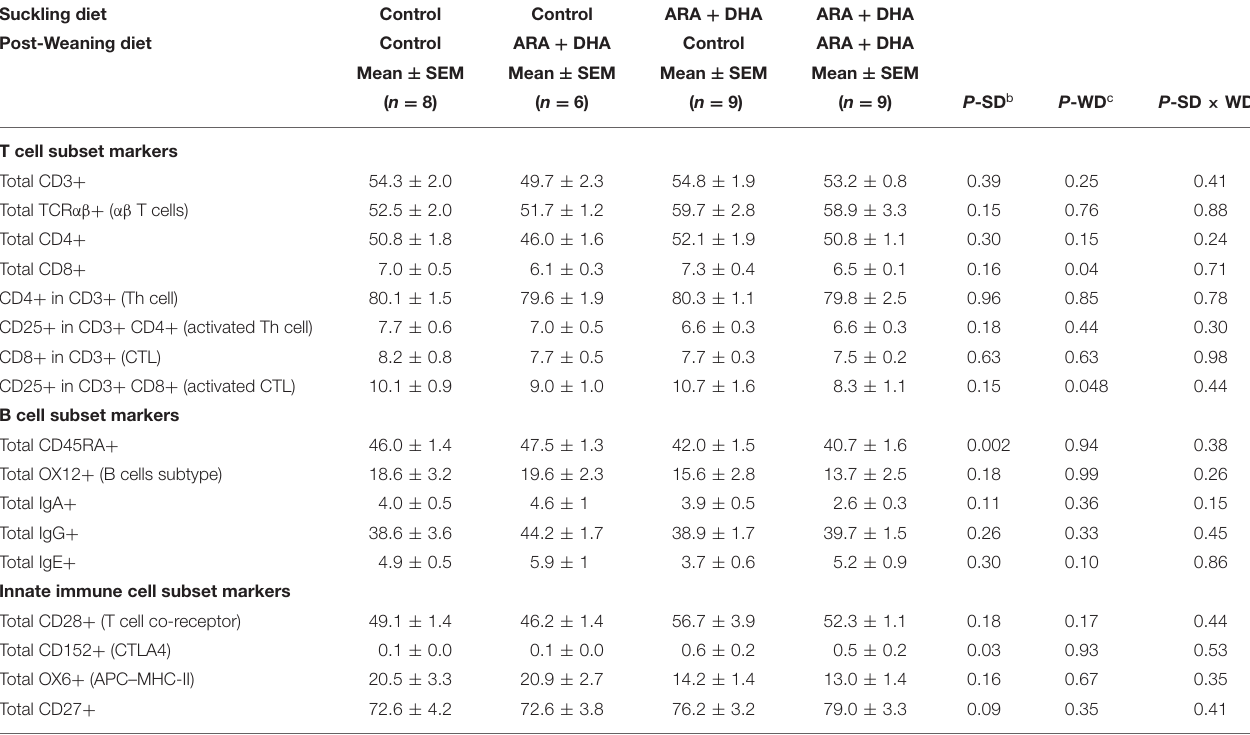
TABLE 5 | The effect of supplementing suckling diet and post-weaning diet on the composition of immune cell types isolated from the mesenteric lymph nodes of 8-week-old Brown Norway offspring a . Suckling diet Control Control ARA + DHA ARA + DHA Post-Weaning diet Control